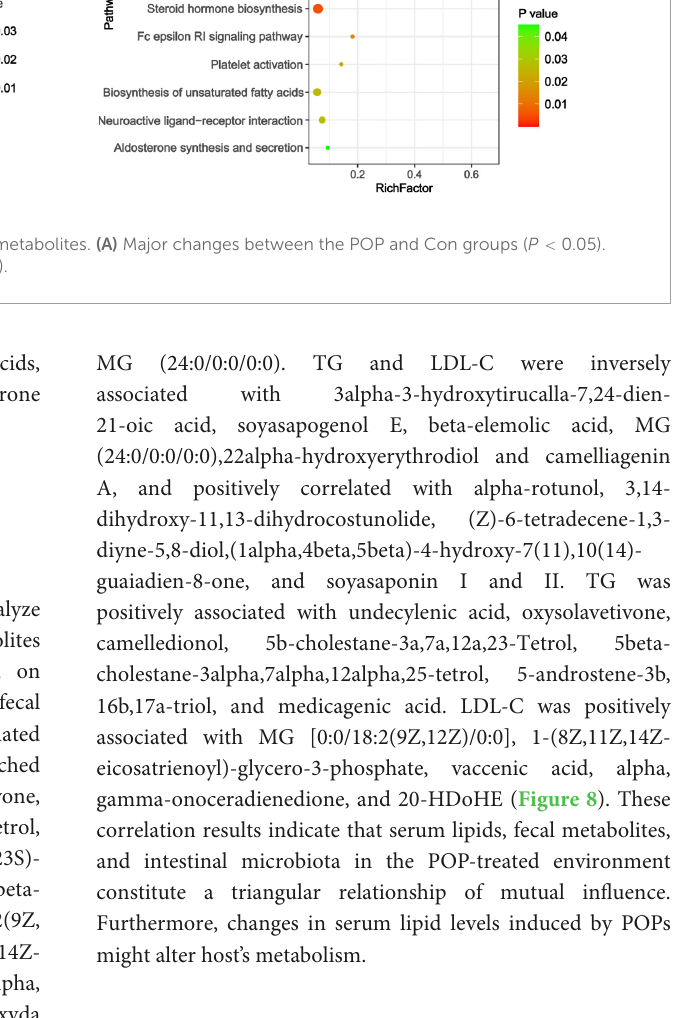
FIGURE7 Changes in the corresponding pathways associated with fecal metabolites. (A) Major changes between the POP and Con groups ( P < 0.05). (B) Major changes between the herb and Con groups ( P < 0.05).